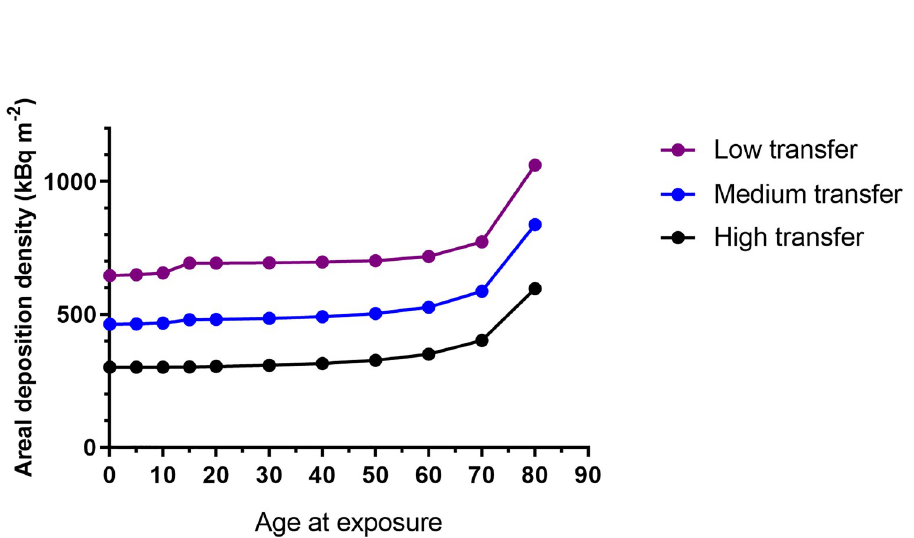
Fig 4. Lifetime effective dose (mSv) up to age 84, E84, for males under various scenarios, as a function of age at the onset of exposure. Note the different scales for three of the high-deposition scenarios.